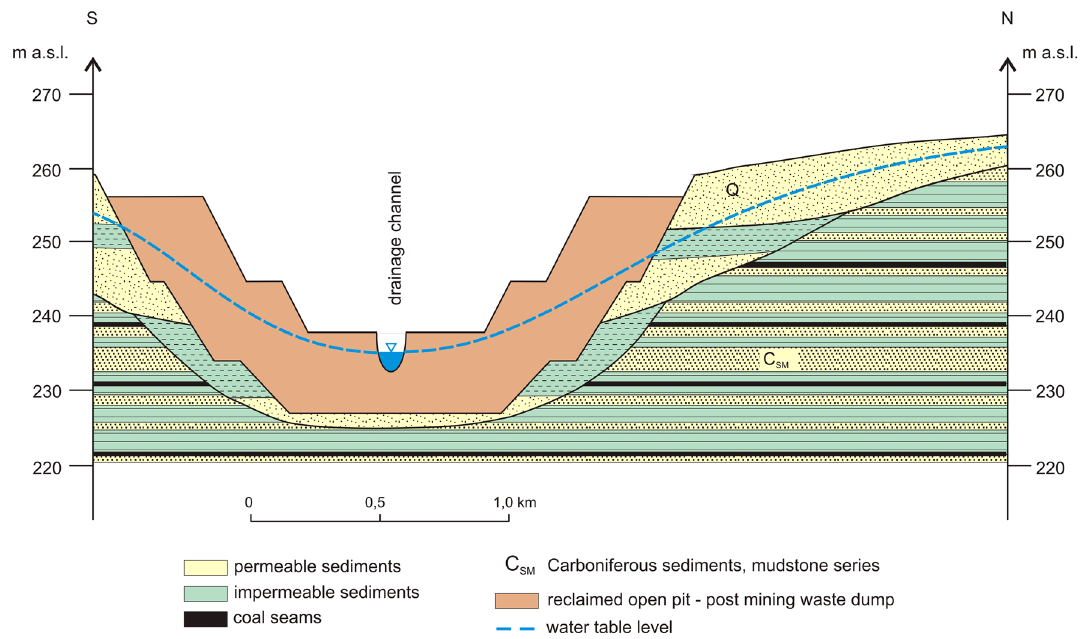
Fig. 2 A schematic hydrogeological cross section through the reclaimed part of open-pit CTL Maczki-Bór